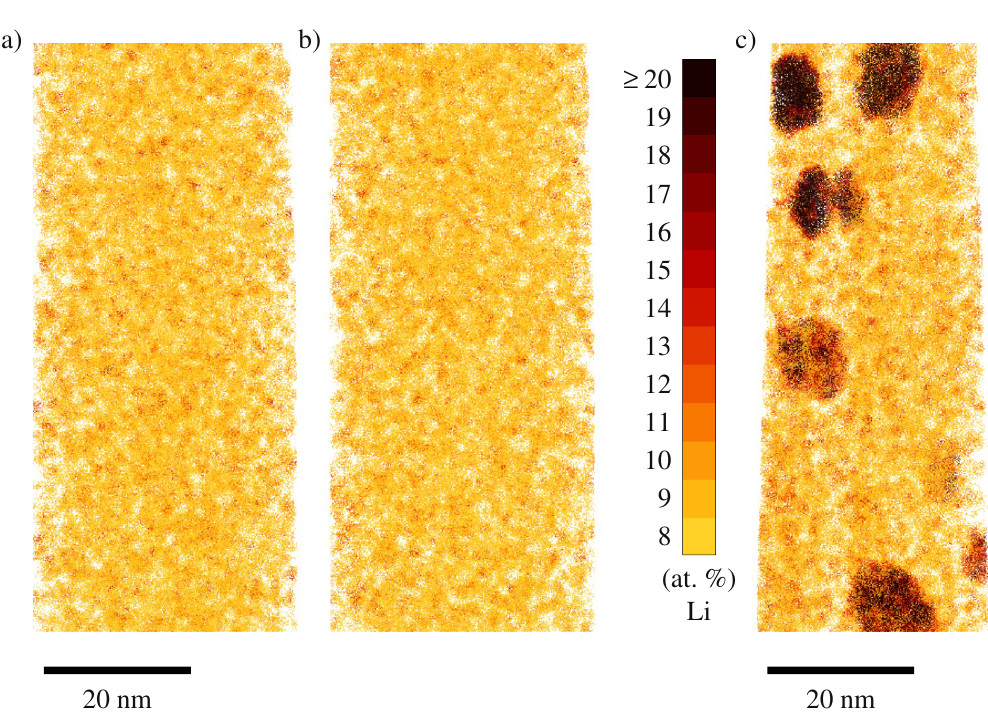
Figure 5. Visual representation of the spatial distribution of Li clusters for randomly labeled data ( a ), the experimentally observed distribution in the 5 minutes at 433 K artificially aged sample ( b ), and the experimentally observed distribution in the 60 minutes at 433 K artificially aged sample ( c ). The central atom of any 100 atom cell is given a color depending on the Li concentration in the respective cell. While bright yellow stands for analysis cells with 8 at.% Li, dark red indicates a Li composition of ≥ 20 at.%